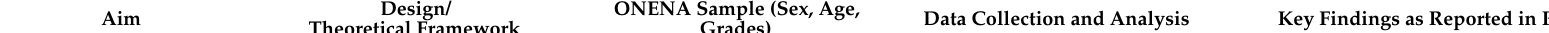
Table 1. Summary of the included qualitative and quantitative studies reporting barriers and facilitators associated with sport/PA